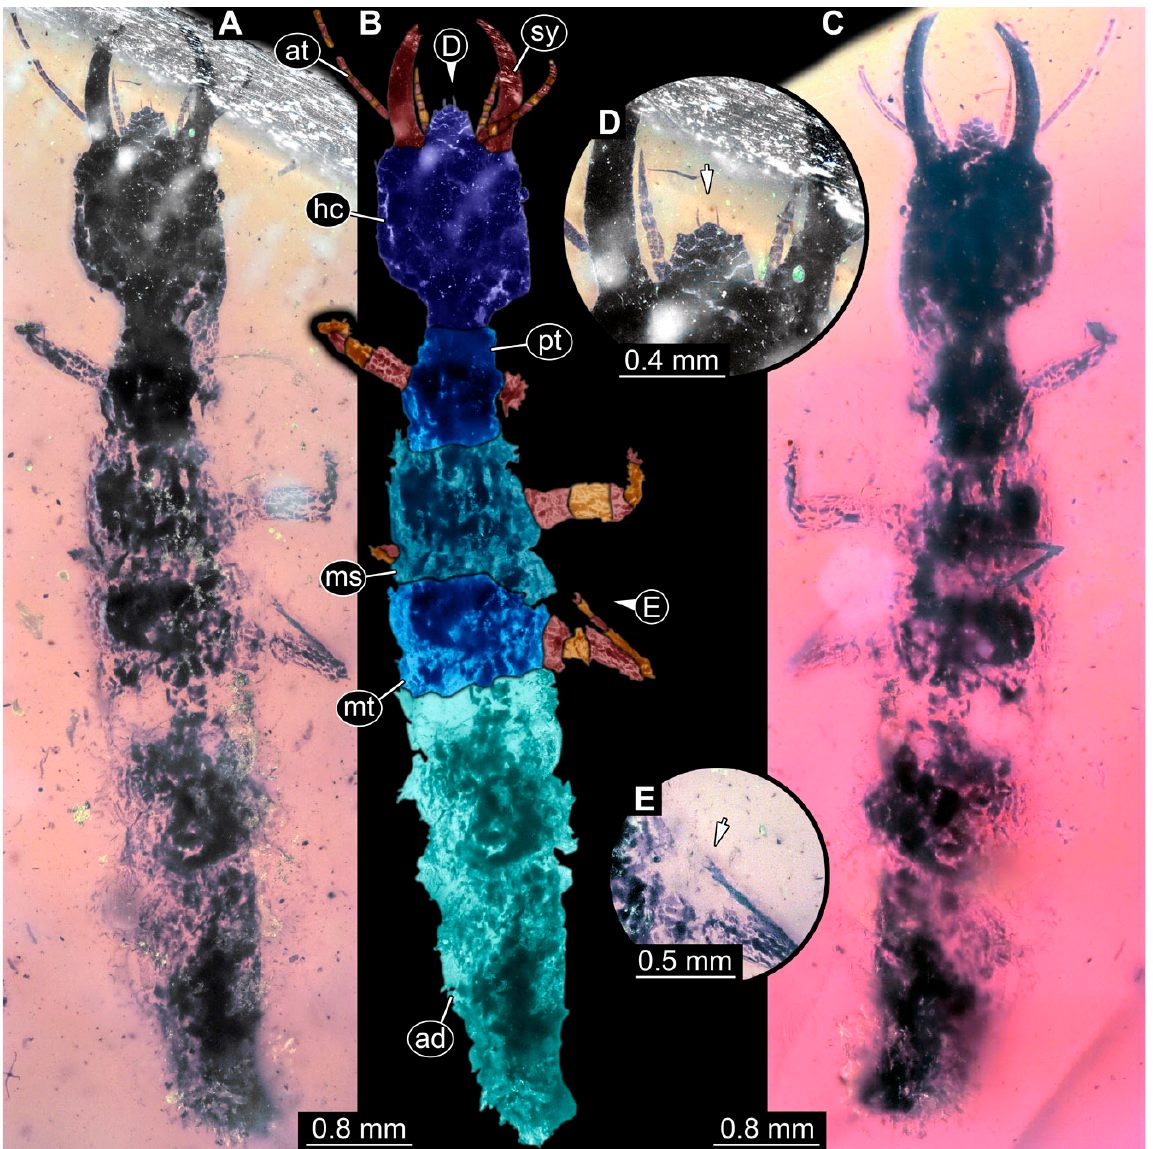
Figure 19. Specimen 80 (PED 1732); Myanmar amber. ( A ) Dorsal view. ( B ) Dorsal view, colour- marked. ( C ) Ventral view. ( D ) Close-up of labrum in dorsal view; arrow marks the labrum. ( E ) Close-up of third locomotory appendage; arrow marks distal end. Abbreviations: ad = abdomen; at = antenna; hc = head capsule; ms = mesothorax; mt = metathorax; pt = prothorax; sy = stylet. (29) Specimen 81 (PED 1813) is preserved in Cretaceous Myanmar amber (Figure 20).